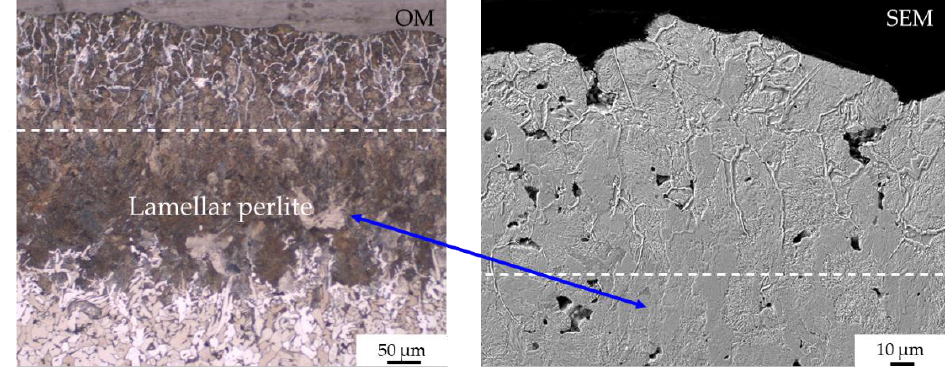
Figure 4. Magnification of zone 2 (sintering with graphite foils without coating): OM (on the left ) and SEM (on the right ) images after chemical etching.